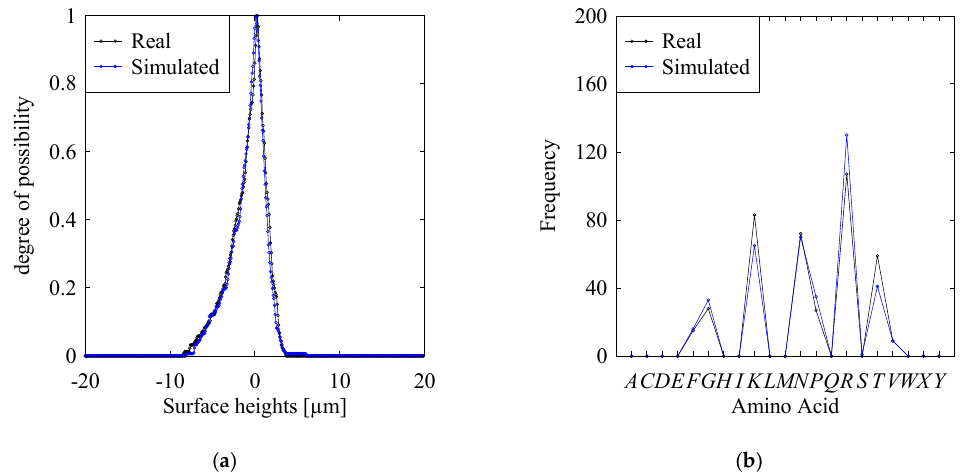
Figure 12. Outcomes of VC corresponding to the semantic modeling-based MC and Monte Carlo simulation-based SC: ( a ) possibility distribution; ( b ) DNA-based computing.